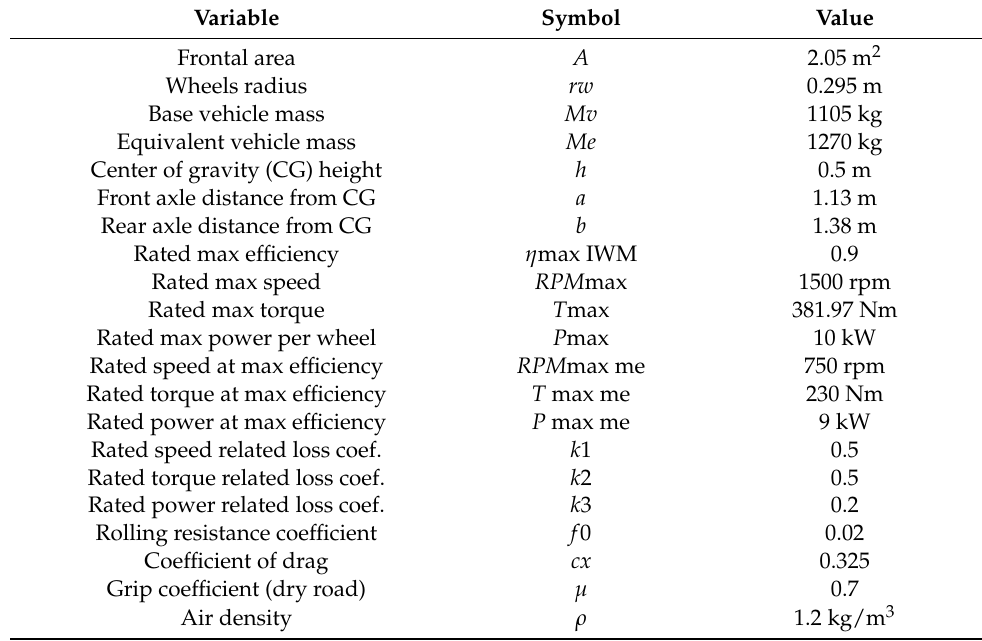
Table 1. Vehicle and hybrid powertrain